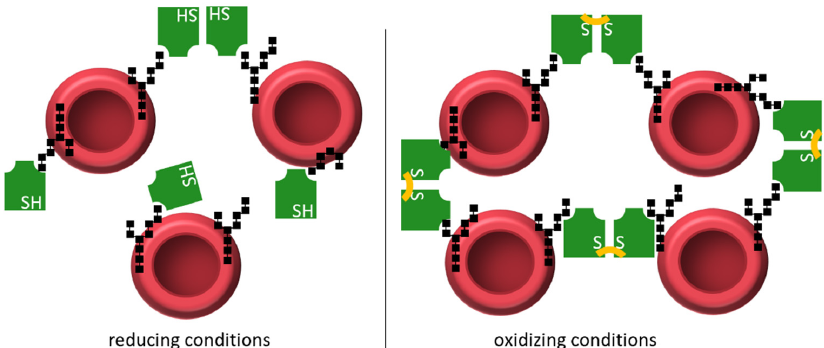
Figure 8. Hemagglutination activity of the Os JAC1-JRL domain (green, with respective functional groups of cysteine and cystine indicated as SH and S-S, respectively) interacting with carbohydrate moieties (black shapes) on the surface of erythrocytes. Under reducing conditions (left), the JRL domain forms a sparse interaction network with the erythrocytes, acting as a monomer or a transient dimer. Under oxidizing conditions (right), two JRL protomers are forming an intermolecular disulfide bond (Cys161-Cys161), which leads to a more organized interaction network and increased hemagglutination activity.